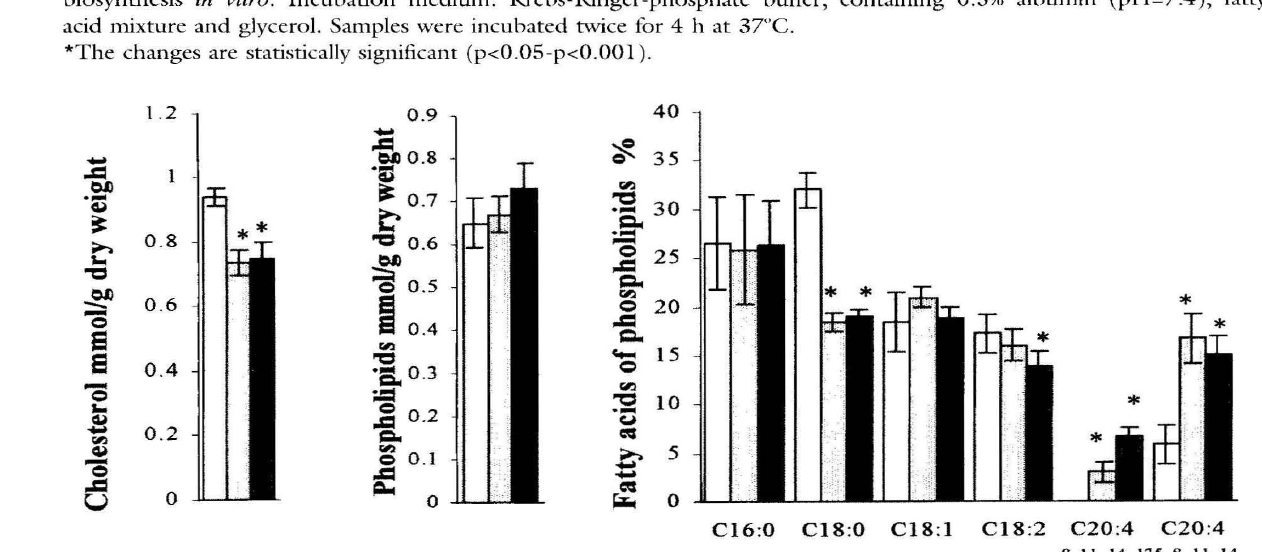
Figure 3. Concentrations (mean±S.D.) of cholesterol and phospholipids, as well as fatty acid content (in percent: mean±S.D.) in controls (open bars) and in samples with S pmoljg wet weight sepiapterin (dotted bars) and 30 pmolj g wet weight sepiapterin (hatched bars). Samples of rat liver tissue homogenates were used to test for phospholipid